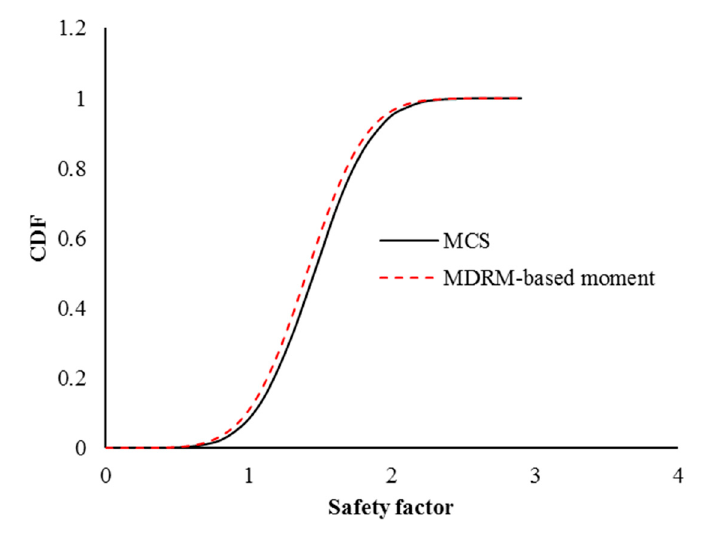
Figure 5. The accumulative density of safety factor.